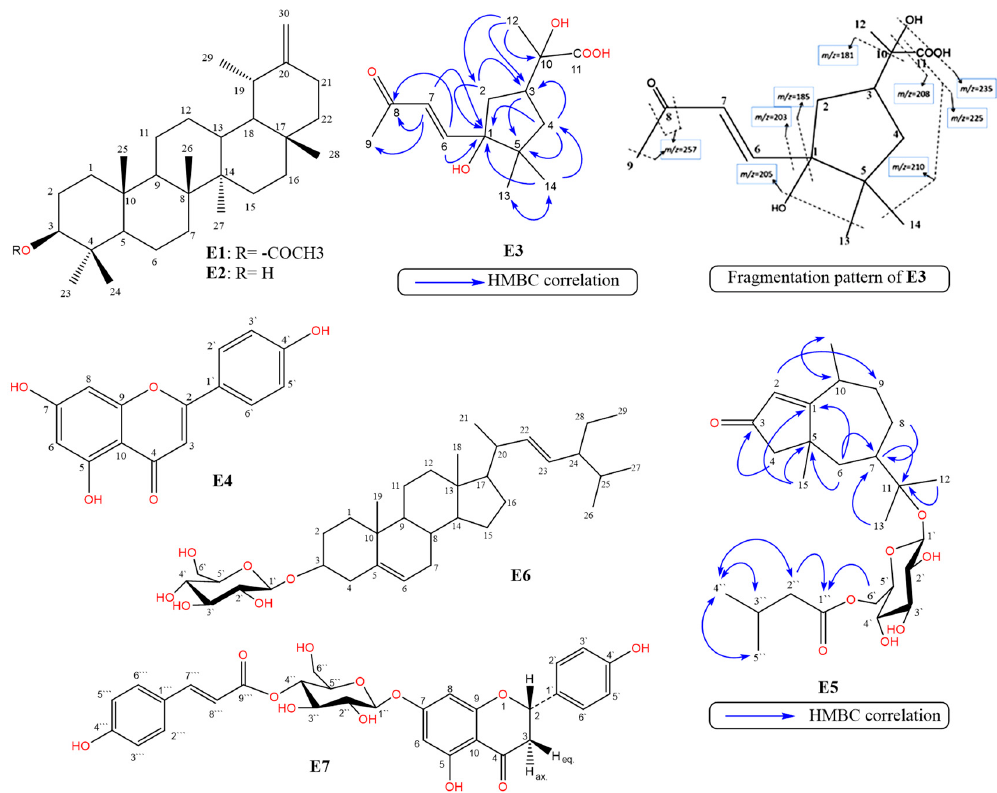
Figure 1. Chemical structures of compounds E1 – E7 , HMBC correlations of E3 and E5 , and mass fragmentation pattern of E3 : Taraxasterol acetate ( E1 ), Taraxasterol ( E2 ), erinaceolic acid ( E3 ), apigenin ( E4 ), erinaceoside ( E5 ), stigmasterol-3- O - β -D-glucoside ( E6 ), and naringenin-7- O - β -D-(4”- trans - p - coumaroyl) glucoside ( E7 ). Table 1. NMR spectral data for the compound E3 in CD 3 OD.